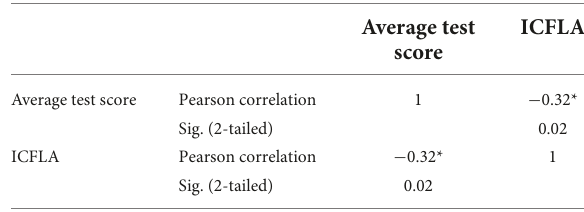
TABLE 4 Pearson product–moment correlation between interpretation classroom foreign language anxiety levels and CI test